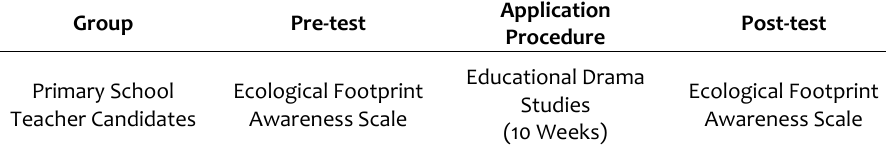
Table 1. Pre-test-post-test single-group semi-experimental